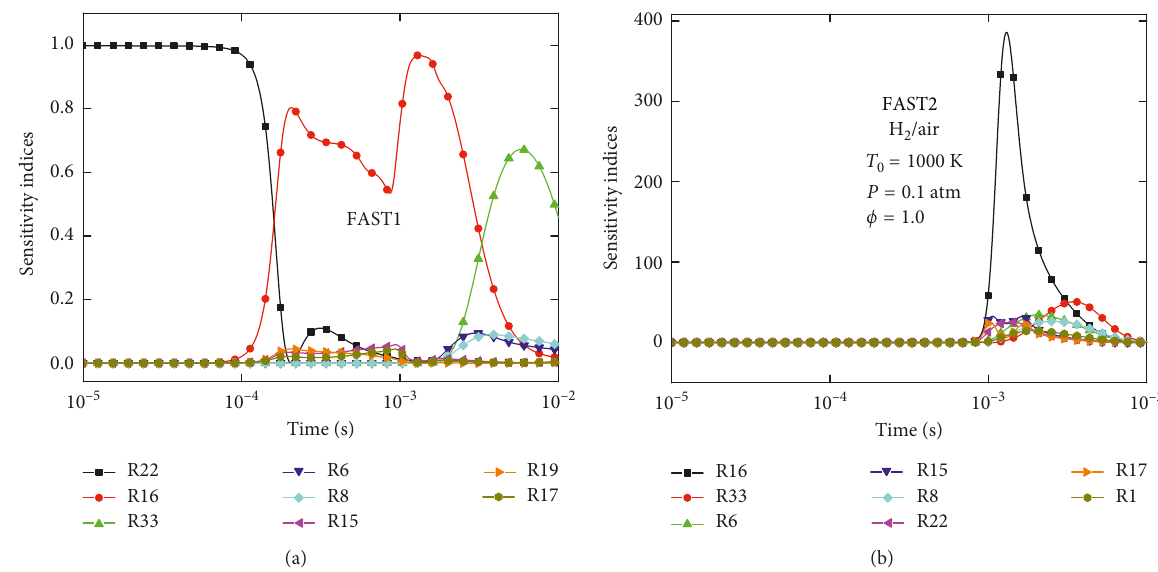
Figure 2: The profiles of sensitivity indices measured by two types of FAST methods. FAST1 means sensitivity indices measured by a variance-based method based on (10), and FAST2 means sensitivity indices measured by (12). R indicates the reaction, and ϕ is the equivalence ratio.